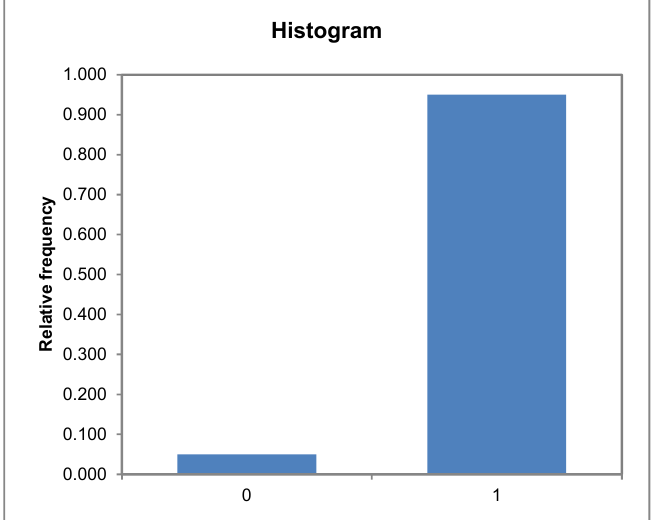
Figure 14. Discretized histogram of the SIM_Exp_Lang variable.